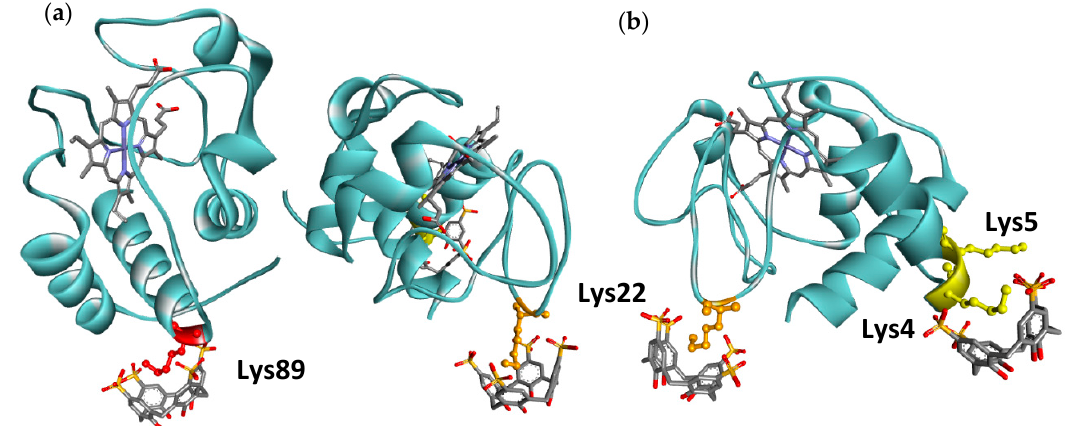
Figure 19. Image of 3TYI (structure obtained by McGovern et al. [131]) created with the software Discovery Studio 2020 Client (BIOVIA, Dessault Syst è mes, San Diego: Dessault Syst è mes, 2020) ( a ) Asymmetric unit of the crystal structure of the cytochrome c-SC4 complex, showing three interact Table 89. (red), Lys22 (orange), and Lys4 (yellow), at the surface of the protein, with respective interactions in bright orange. ( b ) Side view of one of the proteins in the asymmetric unit for better visualization of the Lys4 binding site; Lys5 is also represented in yellow, for it could form complementary interactions with the SC4 molecule in its proximity.